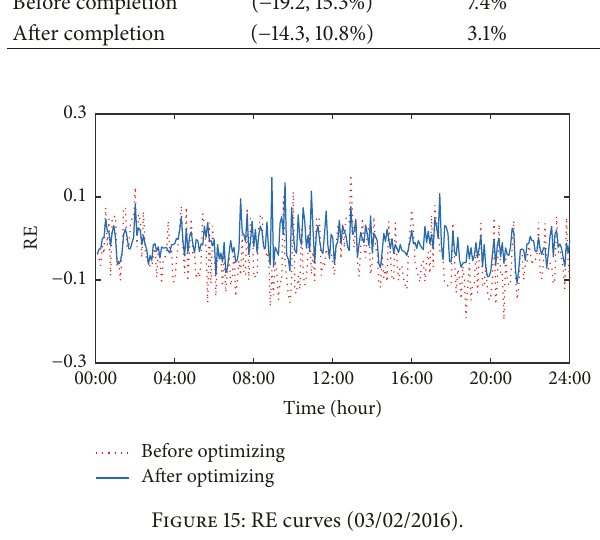
Figure 18: Travel time prediction result curves (03/05/2016).